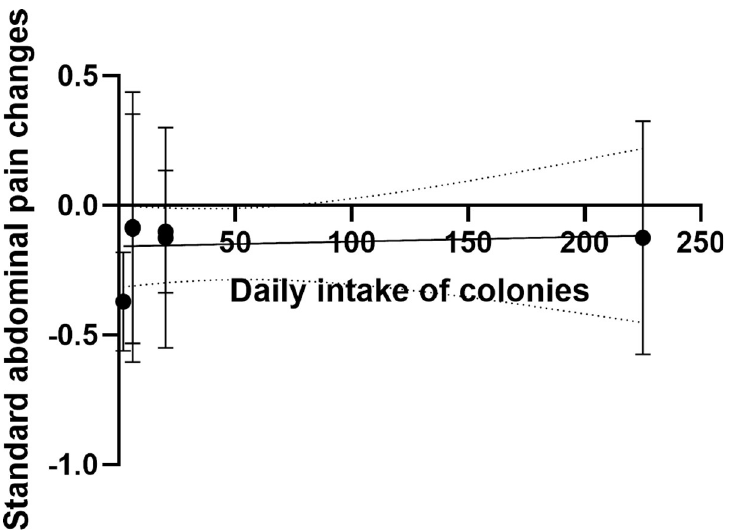
Fig 5. The relationship between daily intake of probiotics and